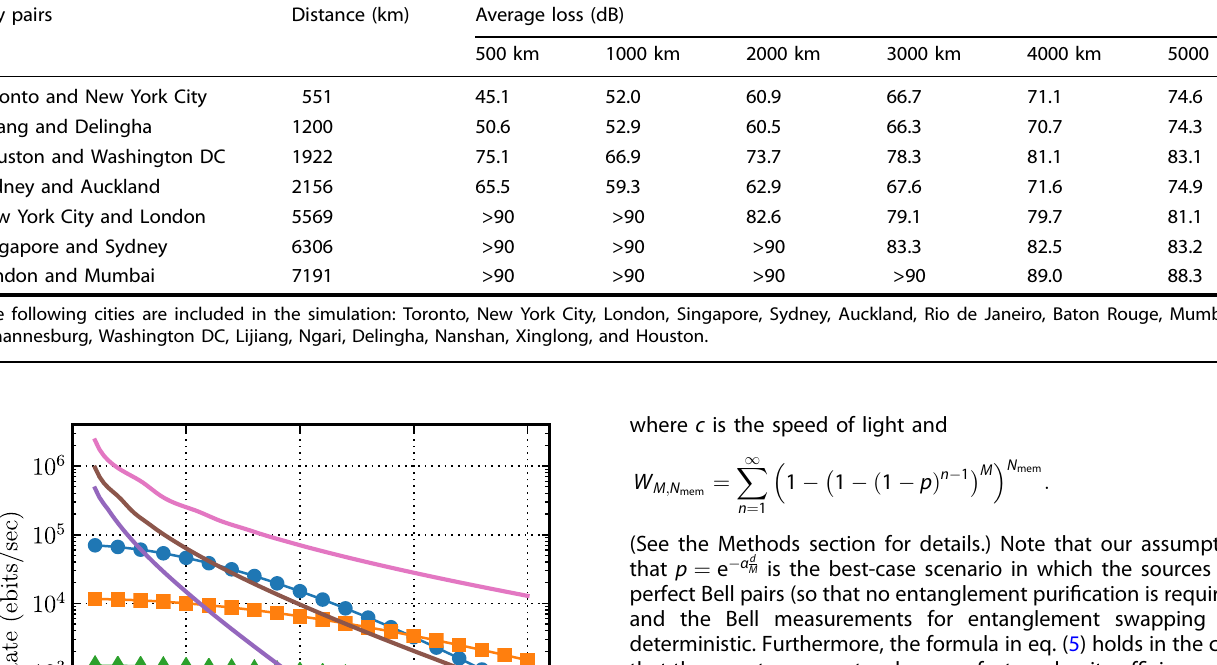
Table 2. Average loss over a 24-h period between select pairs of major global cities for a constellation of 400 satellites ( N R = N S = 20) at various altitudes. City pairs